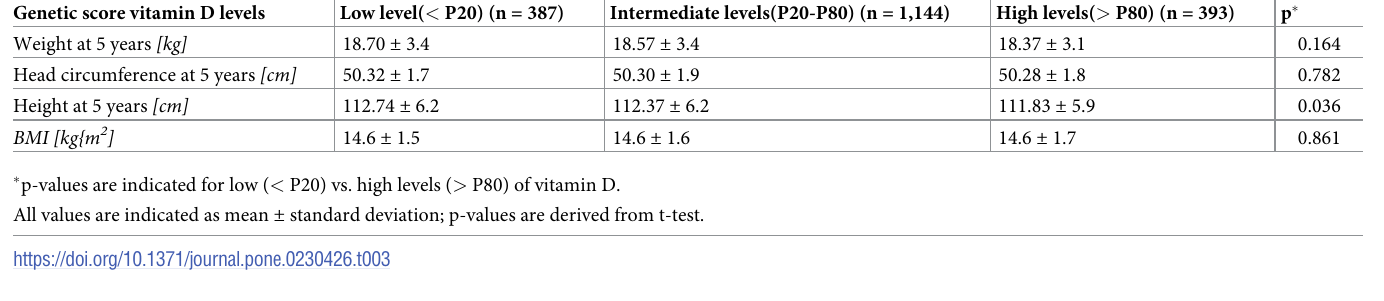
Table 3. Body measurements at the follow-up examination after five years. Genetic score vitamin D